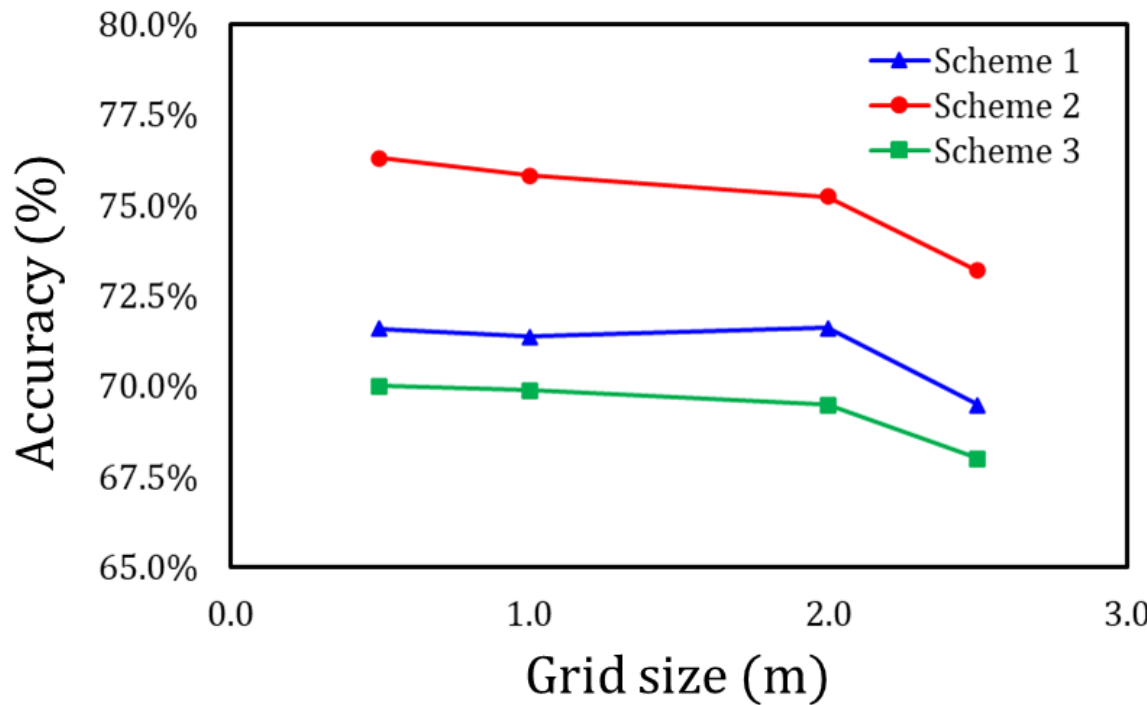
Figure 9. Accuracy curves of the CMC model at different grid sizes (100 cyc.).